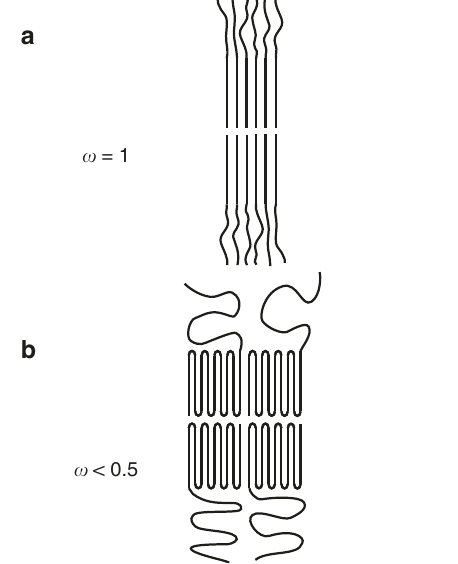
when ω < 0.5 giving signi fi cant coiling. In ROPI-CDSA, PLLA 45 - b -PEG 45 (10% solids w/w 9 ) has a denser corona, in-between ω = 1 and ω < 0.5. In contrast, PLLA 90 - b -PEG 45 (10% solids w/w 15 ) has a ω < 0.5 exhibiting more